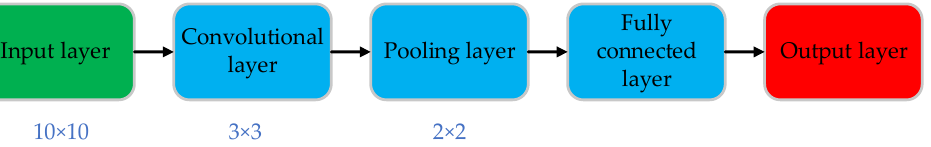
Figure 1. Prototypical CNN unit.